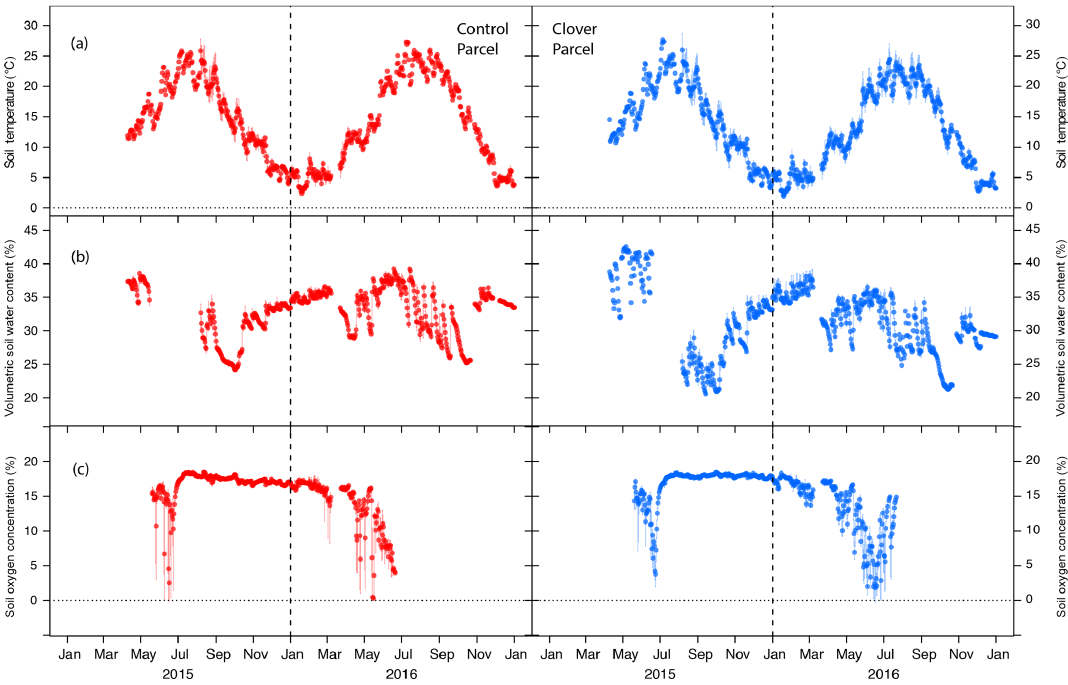
Figure 3. Soil meteorological conditions during 2015 and 2016. (a) Average daily soil temperature (0.1m of depth), (b) average daily soil water content (0.1m of depth), and (c) average daily soil oxygen concentration (0.1m of depth) at the control (left, red) and clover parcel (right, blue). The bars indicate the sub-daily variability (ranges of 10min